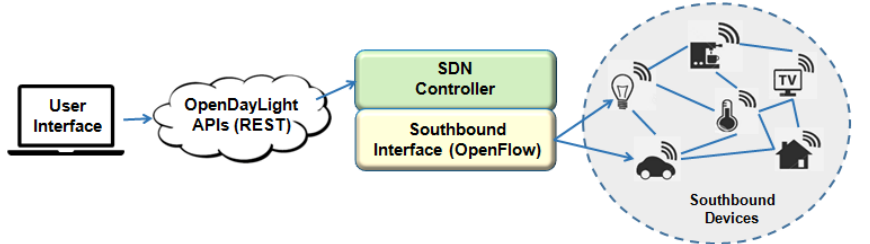
Figure 14. Illustration of the OpenDayLight